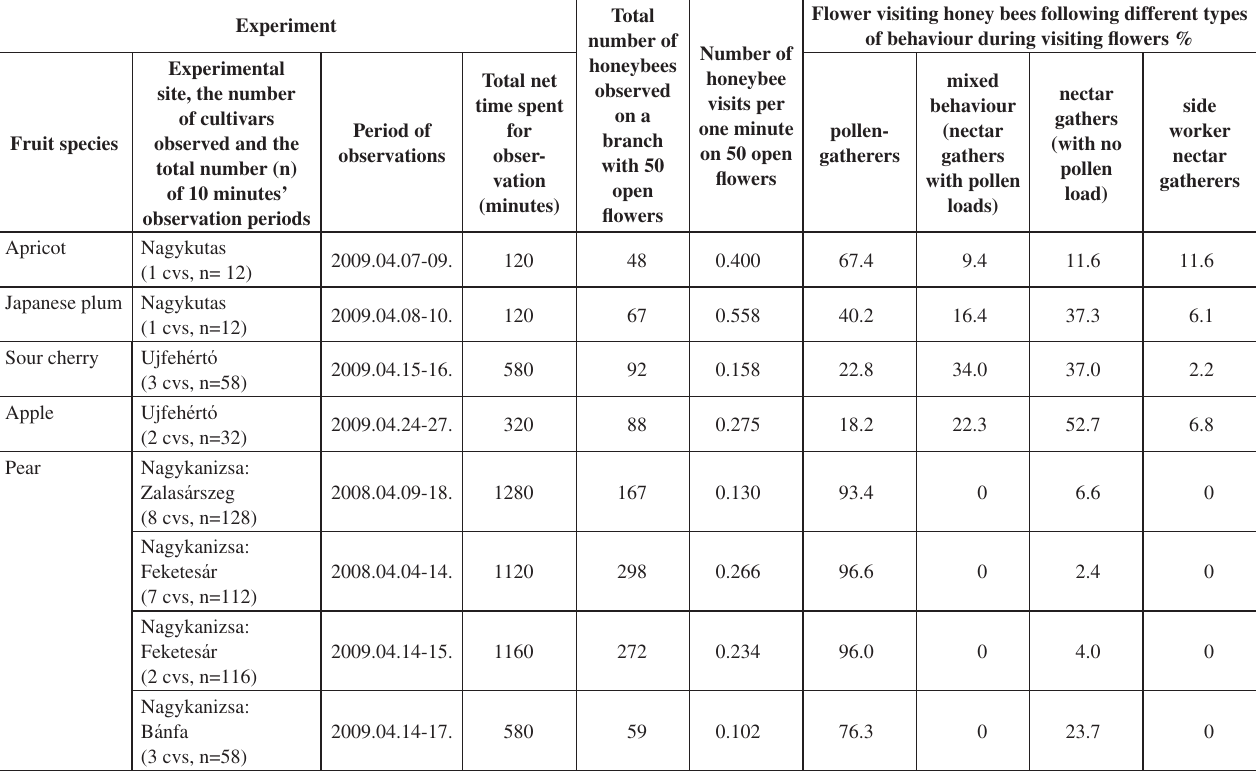
Table 1 – Intensity of honeybee visitation and the fl ower visiting behaviour of honeybees in fl owering commercial plantations of different fruit tree